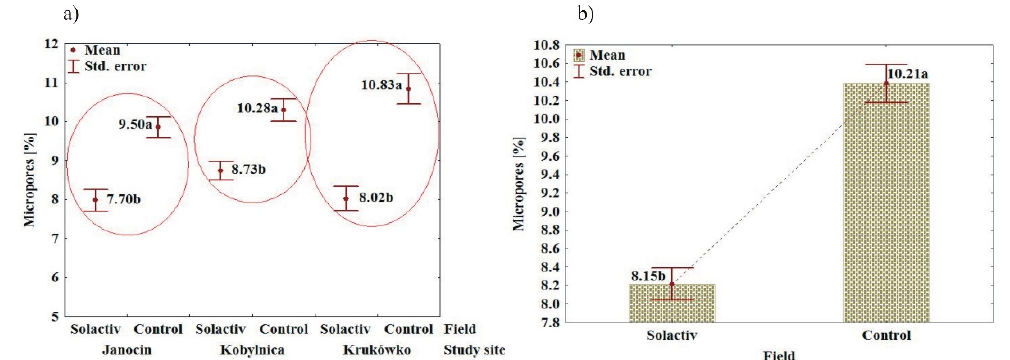
Figure 7. Soil AWC as affected by the tested conditioner. ( a ) The means for individual study sites ( n = 10); ( b ) the means for all study sites ( n = 30). Data were analyzed using one-way ANOVA. Mean values for the conditioner and control followed by different letters are significantly different at p ≤ 0.05 according to Tukey’s HSD Test.